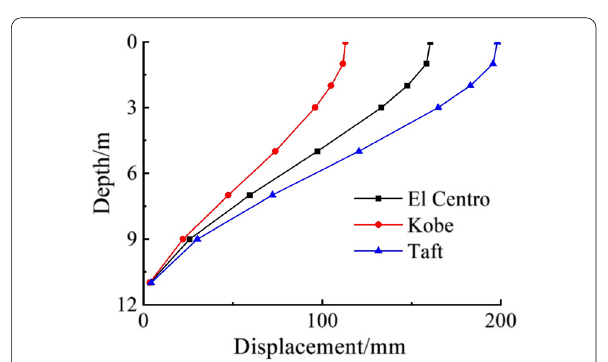
Fig. 20 Seismic subsidence at different soil depths due to different ground motions